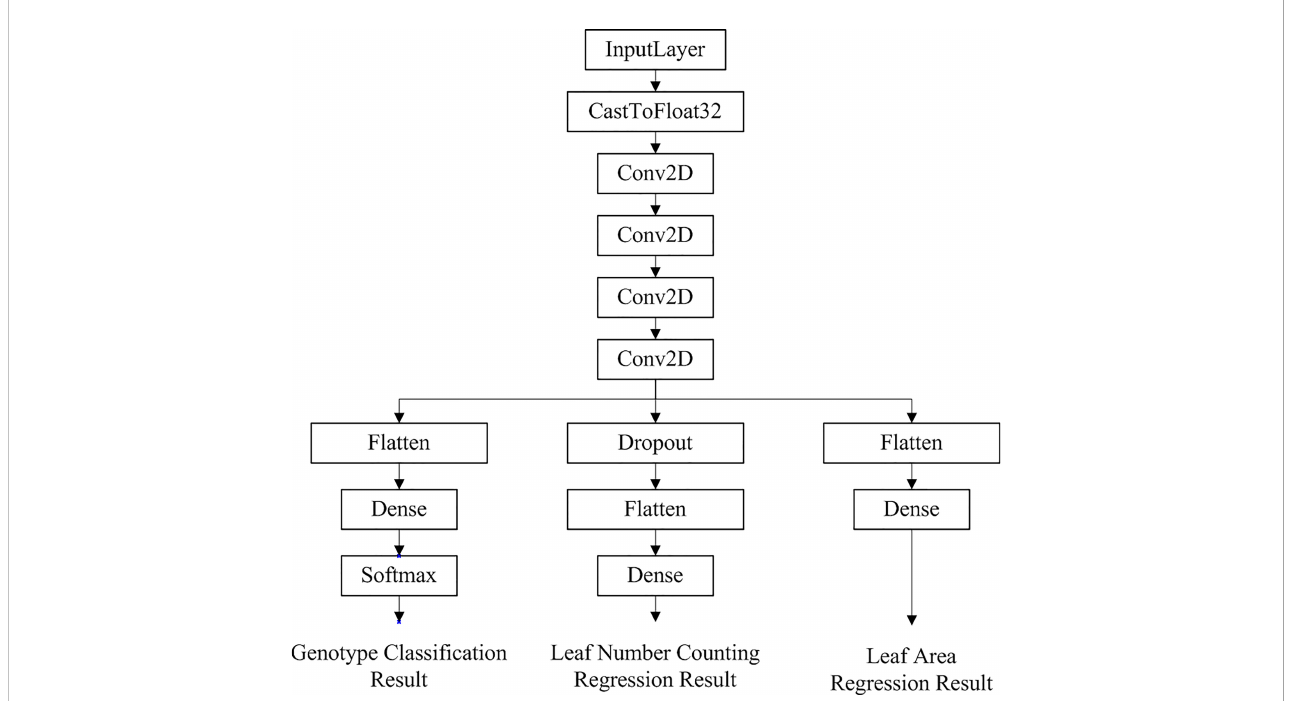
FIGURE 5 Network structure of the optimal multi-task learning model generated by Auto-Keras for Arabidopsis thaliana phenotype reasoning